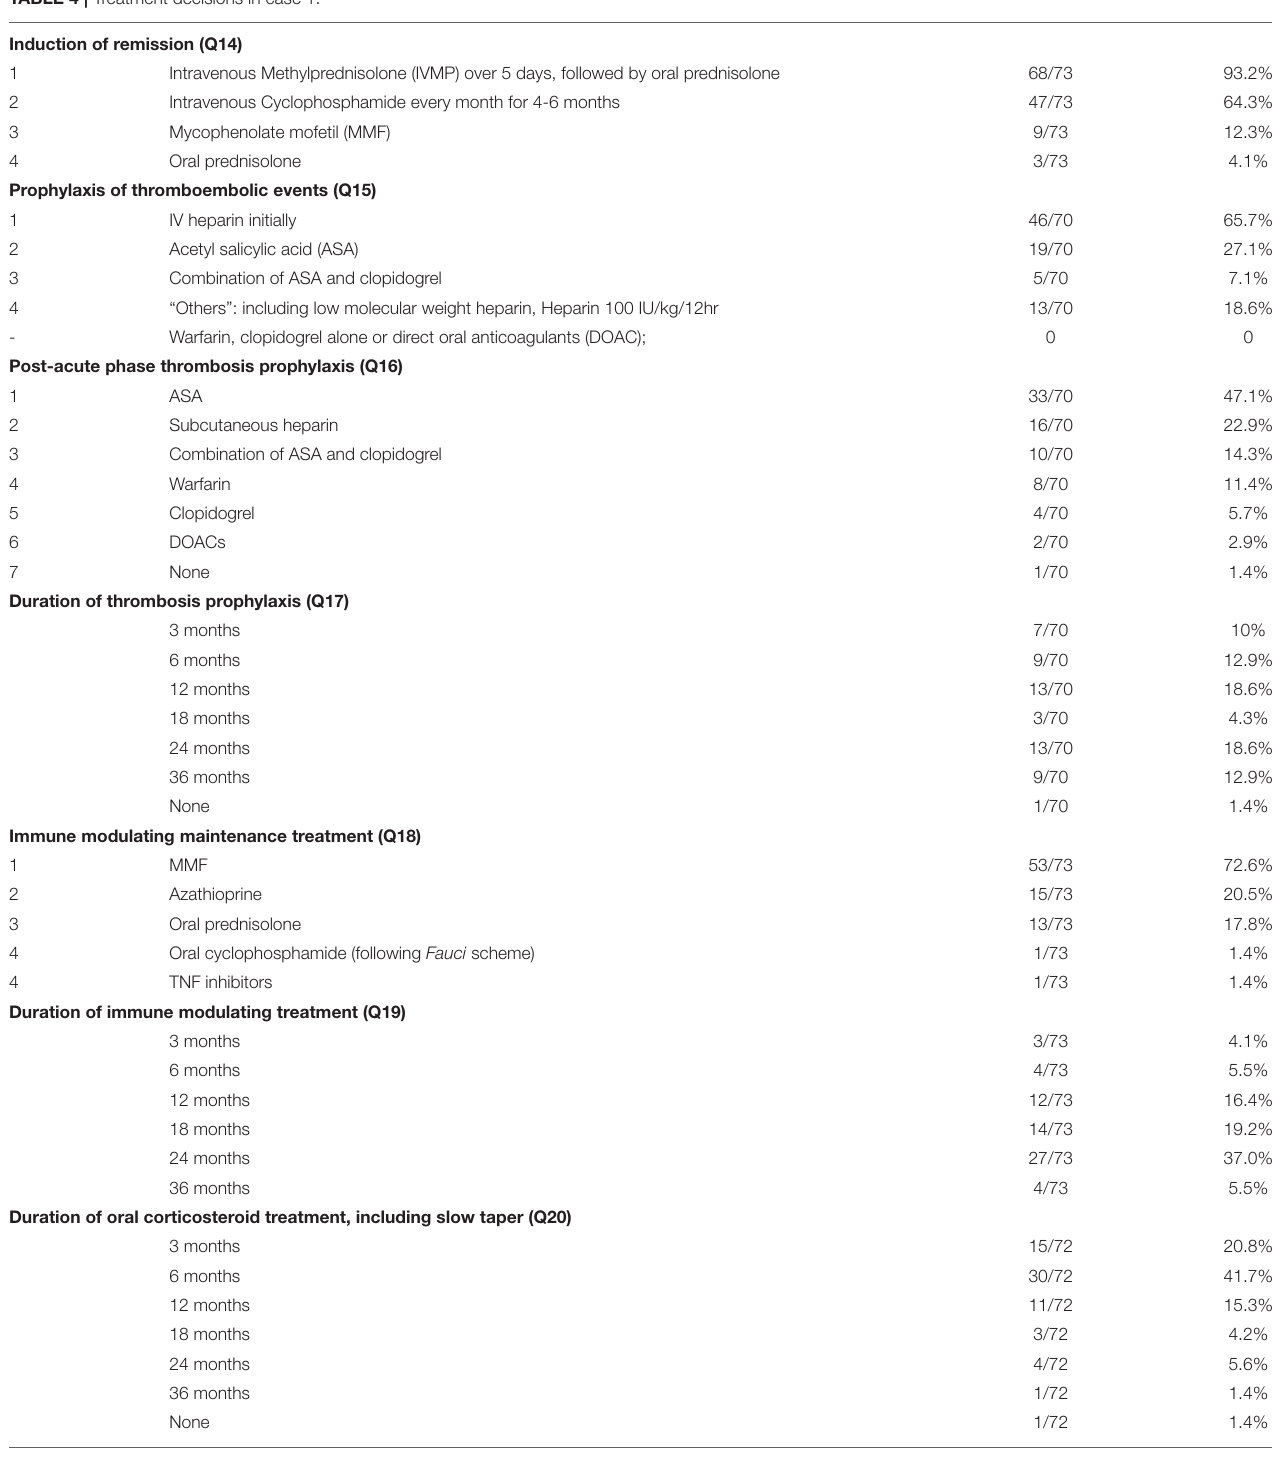
TABLE 4 | Treatment decisions in case